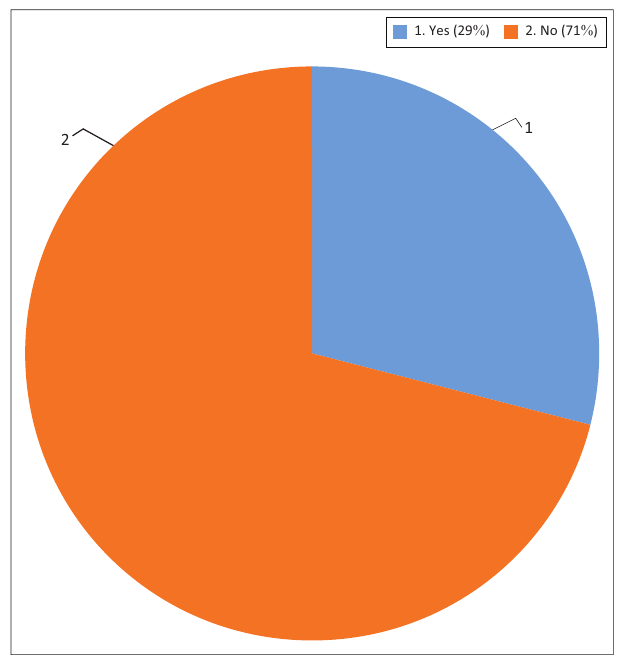
FIGURE 8 : Community participation in disaster risk reduction